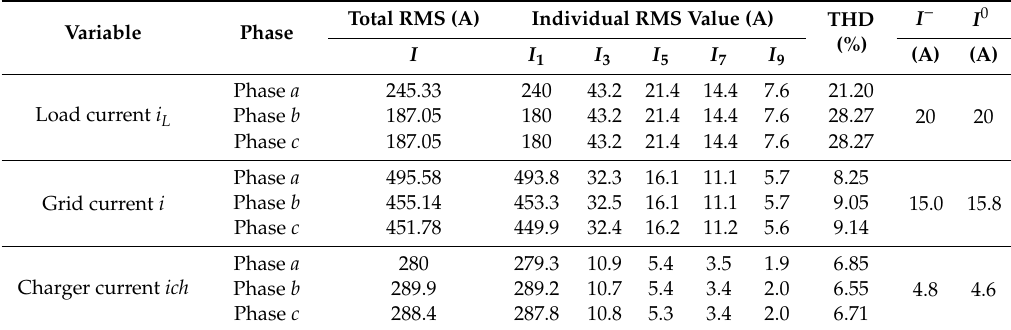
Table 8 . Power terms according to Standard IEEE-1459:2010.